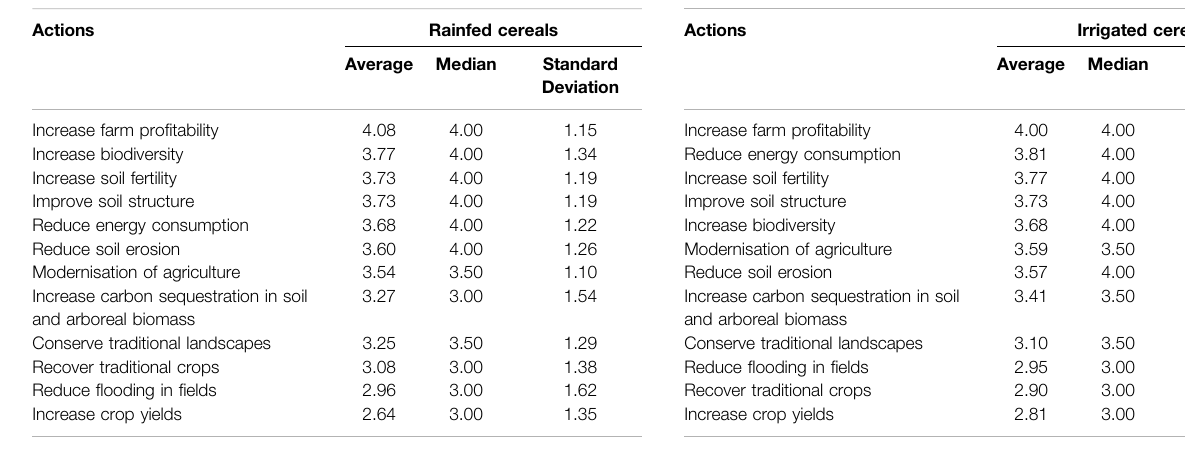
TABLE 4 | Stakeholders ’ qualitative subjective assessment of the priority for actioninirrigatedcereal-basedcroppingsystems,measuredona0to5scale (i.e., 0 = Very low/null, 5 = Very high) and listed in a decreasing order.